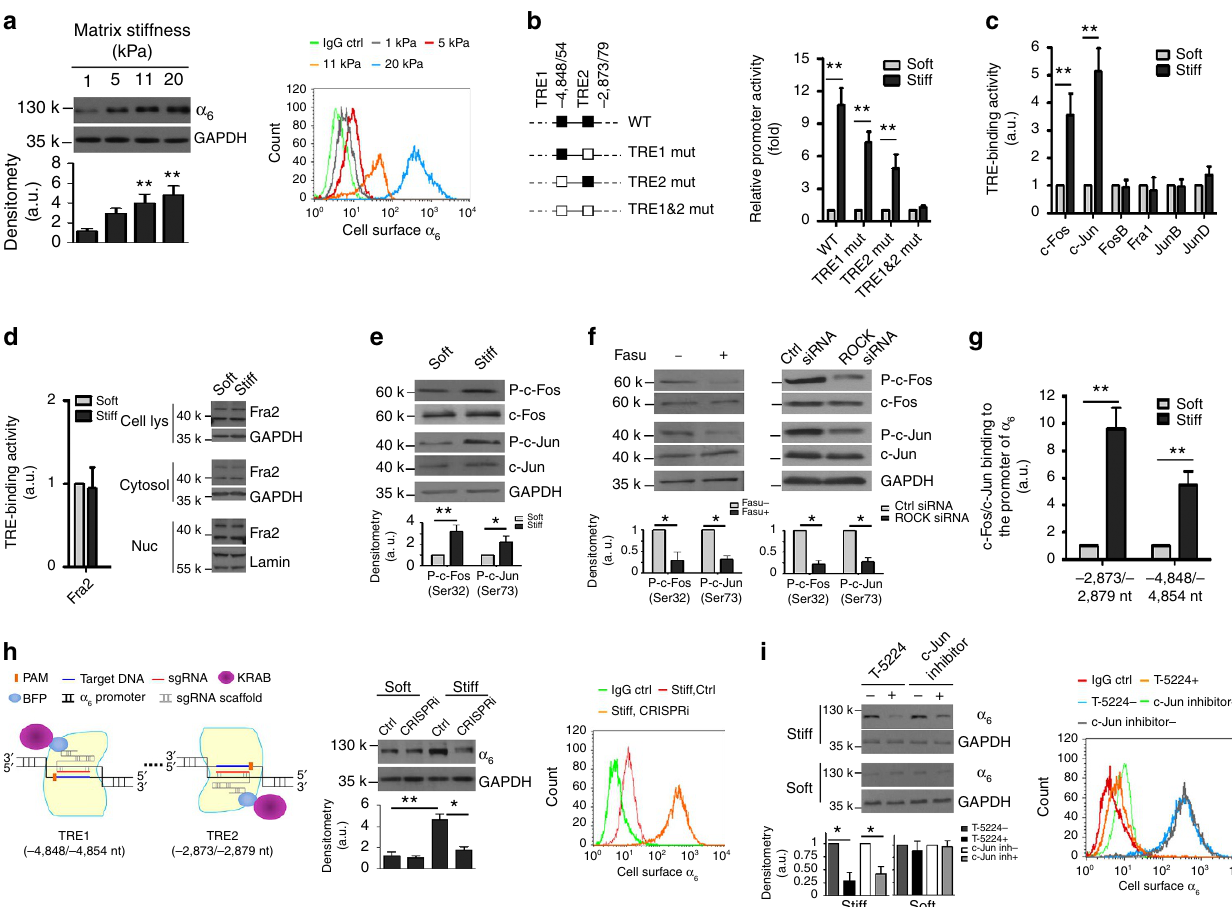
Figure 1 | Stiff matrix upregulates a 6 -expression by ROCK-dependent activation of c-Fos/c-Jun transcription complex. ( a ) IPF lung myofibroblasts were cultured on PA hydrogels with increasing stiffness (1, 5, 11 and 20kPa). Levels of a 6 -protein were determined by immunoblot and flow cytometry, respectively. In flow cytometry, non-immune rat IgG2a, k was used as isotype IgG control. ( b ) Schematic shows the WTand mutated human a 6 -promoters. Promoter activities were determined by luciferase assay. ( c ) Nuclear extracts from myofibroblasts cultured on soft and stiff matrix were incubated with immobilized oligonucleotides containing TREs. The TRE-binding activities of six AP-1 components as indicated were quantified by colorimetric enzyme- linked immunosorbant assay (ELISA). ( d ) The TRE-binding activity of Fra2 in nuclear extracts was quantified by colorimetric ELISA. Levels of Fra2 protein in cell lyates, cytoplasmic and nuclear fractions were determined by immunoblot. ( e ) Protein levels of phospho and total c-Fos and c-Jun under soft versus stiff matrix conditions were determined by immunoblot. ( f ) Effects of ROCK inhibitor Fasudil (Fasu) and ROCK-specific siRNAs on stiff matrix-induced phosphorylation of c-Fos and c-Jun. ( g ) The binding of c-Fos/c-Jun complex to the a 6 -promoter under soft versus stiff matrix conditions was measured by quantitative chromatin immunoprecipitation. ( h ) Schematic shows sgRNA-mediated targeted expression of KRAB transcription repressor at the distal TRE1 and the proximal TRE2 regions in human a 6 - promoter. Effects of CRISPRi-based disruption of c-Fos/c-Jun-dependent promoter activation on stiff matrix- induced a 6 - expression were evaluated by immunoblot and flow cytometry analyses. Control (Ctrl) indicates cells transfected with empty vector. ( i ) Effects of c-Fos/c-Jun inhibitors (T-5224 and c-Jun peptides) on matrix stiffness-regulated a 6 -expression were evaluated by immunoblot and flow cytometry. Results are the means ± s.d. of at least three separate experiments; * P o 0.05; ** P o 0.01; one-way analysis of variance. a.u., arbitrary